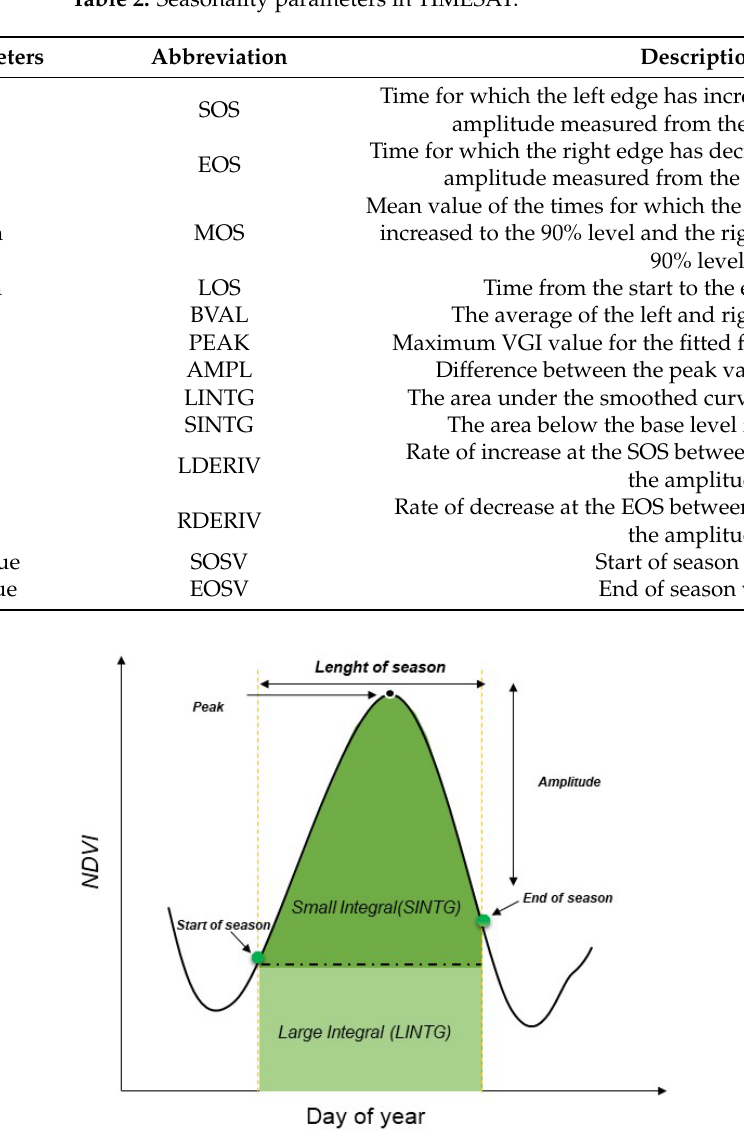
Figure 4. Phenological parameters of the crop growing season used in this study.